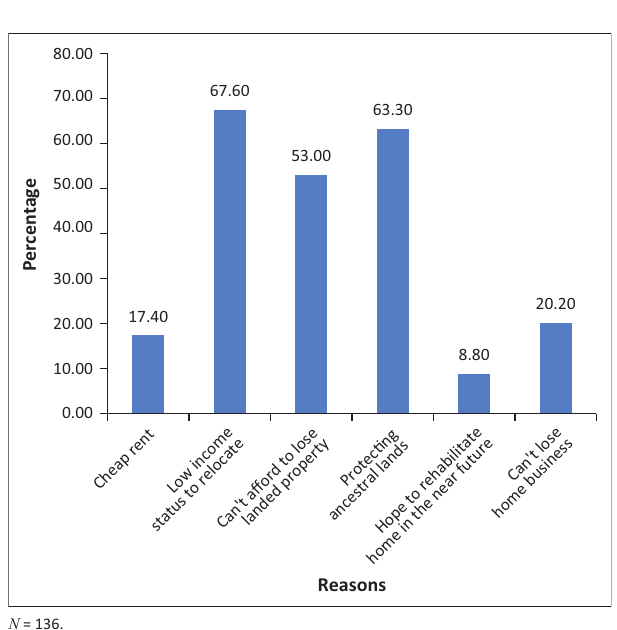
FIGURE 6: Self-reported reasons hampering relocation after flooding